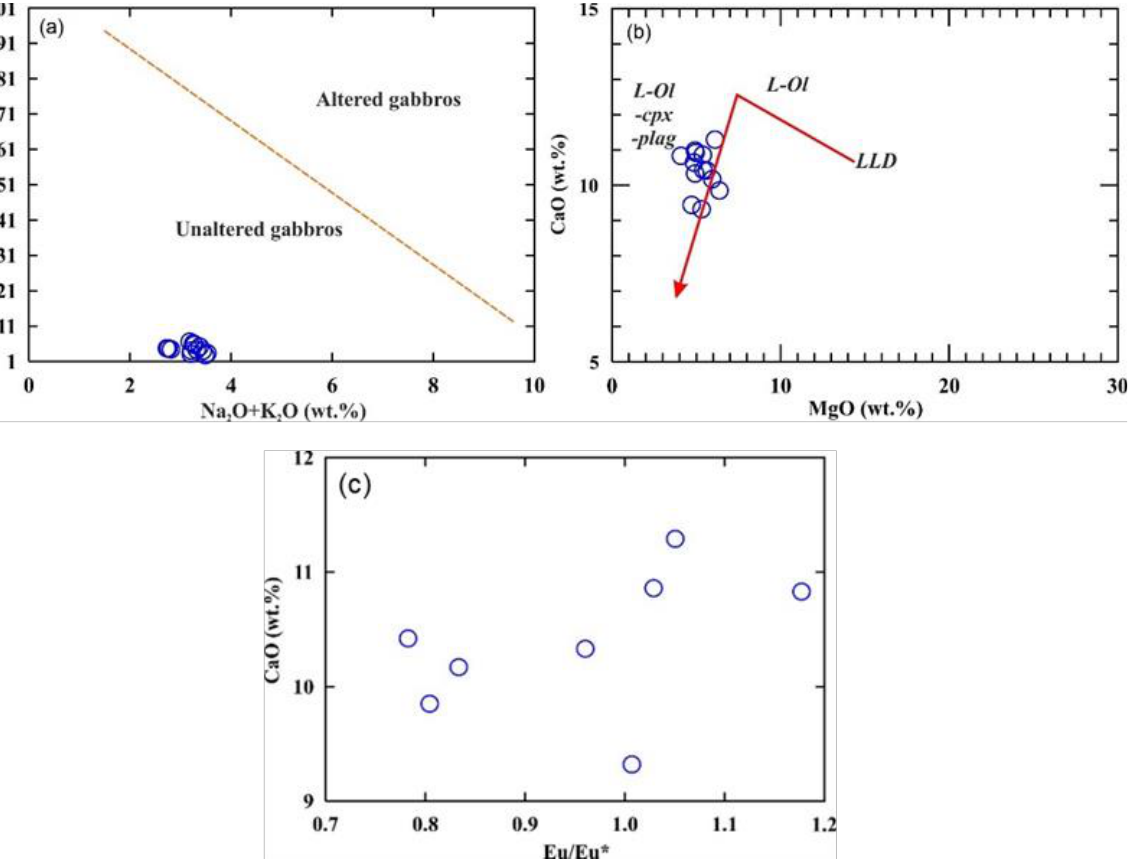
Figure 6. ( a ) Plot of Na 2 O + K 2 O vs. Na 2 O/K 2 O [53], showing the unaltered nature of the rocks; and ( b ) plot of MgO vs. CaO. The red broken arrow is the typical liquid line of descent (LLD) for primary magmas that crystallize gabbro in the crust [54]; and ( c ) plot of Eu/Eu* vs. CaO.